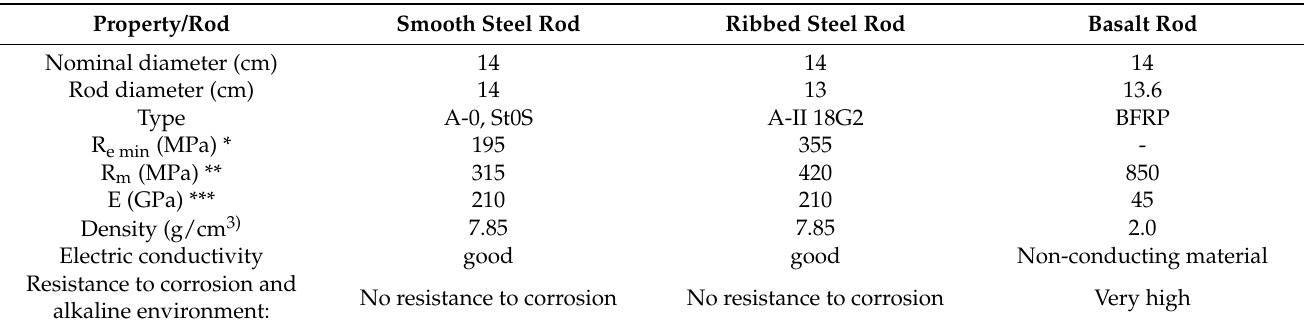
Table 1. Physical and mechanical properties of tested rods.